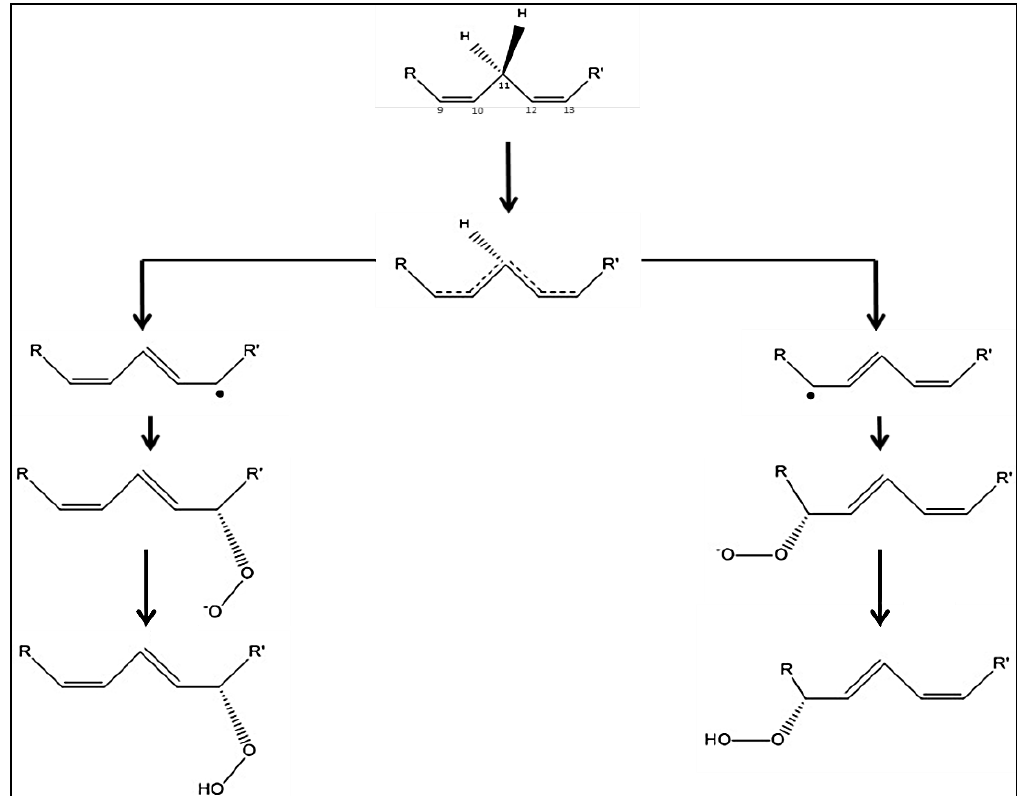
Figure 4. Reaction mechanism of vegetable lipoxygenases. R and R ‘ respectively represent the carboxylate and methyl ends of the fatty acid. The abstraction of hydrogen on the C11 of the (1Z, 4Z)-pentadiene system of linoleic or α -linolenic acid, induces an electronic delocalization on the five carbons of the pentadiene system. The antarafacial insertion of molecular dioxygen at the position {n + 2} (left part) or {n − 2} (right part) leads to the formation of a peroxide anion, which is finally protonated to give a 9- or 13-hydroperoxide.